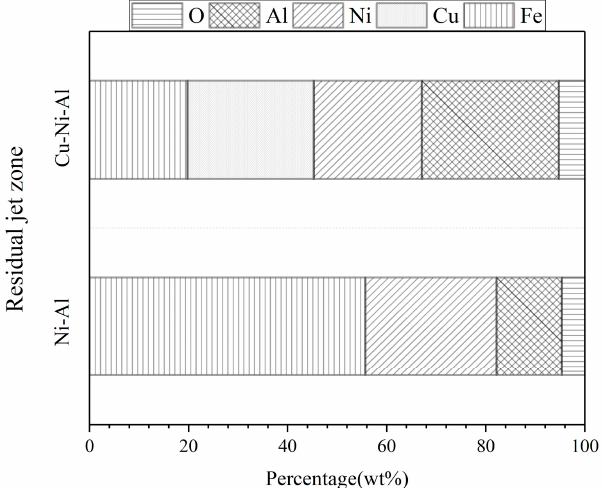
Figure 9. The point EDS results of Ni-Al and Cu-Ni-Al residual jet zone.